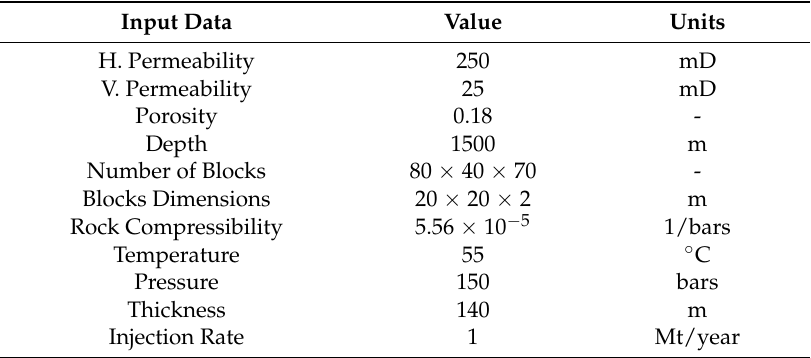
Figure 1. The 3D reservoir simulation model showing the horizontal heterogeneous permeability. Table 1. Input data for the basic model